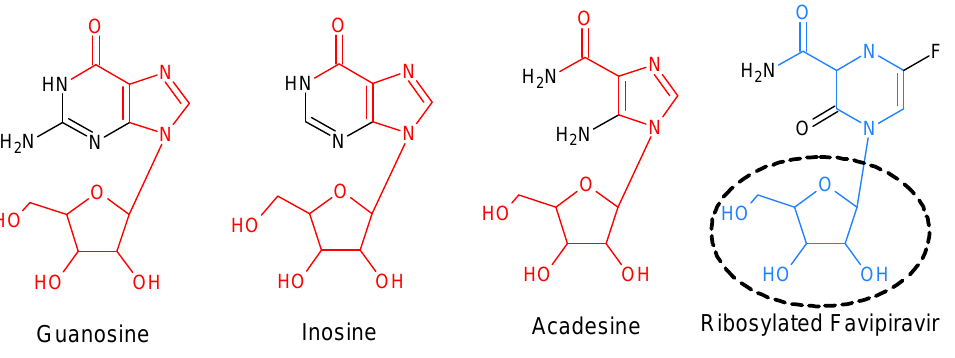
Figure 1. Similar Chemical